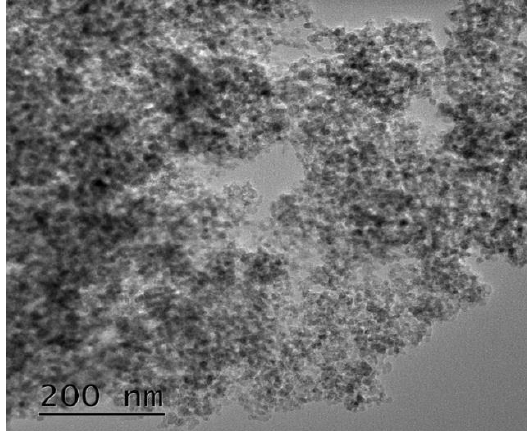
Figure 2. TEM image of Al 2 O 3 nanoparticles.